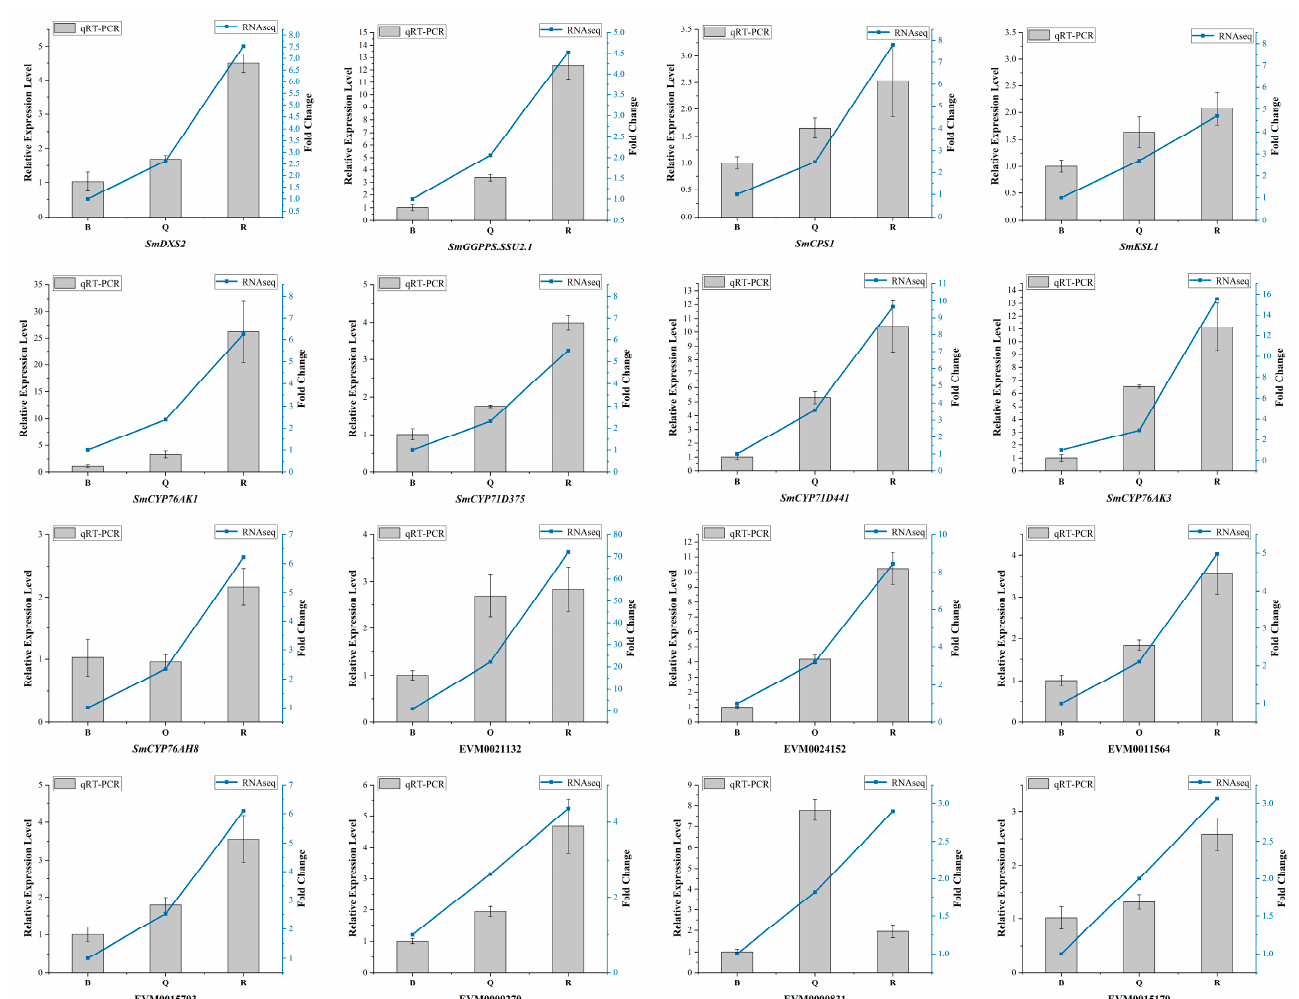
Figure 5. The qRT-PCR analysis of DEGs selected by transcriptome data. The standard deviation was represented by the error bars.